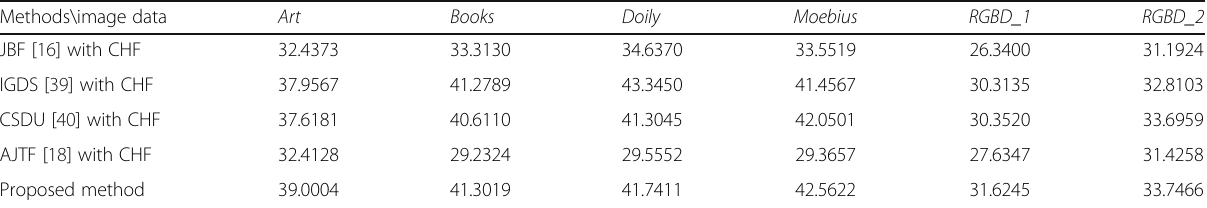
Table 1 PSNR comparisons with different approaches on Middlebury dataset and RGBD dataset Methods\image data